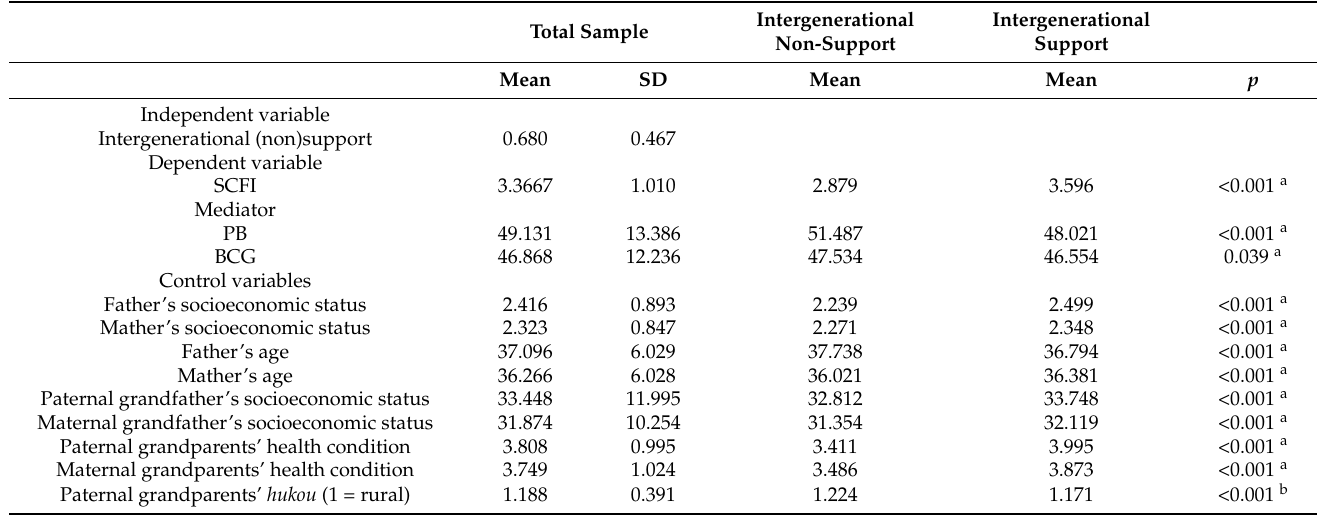
Table 3. Study sample characteristics, stratified by support status, before CEM and